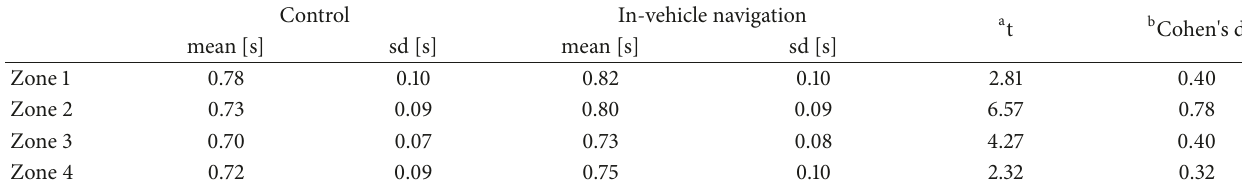
Table 4: Statistical results of the R-R interval.